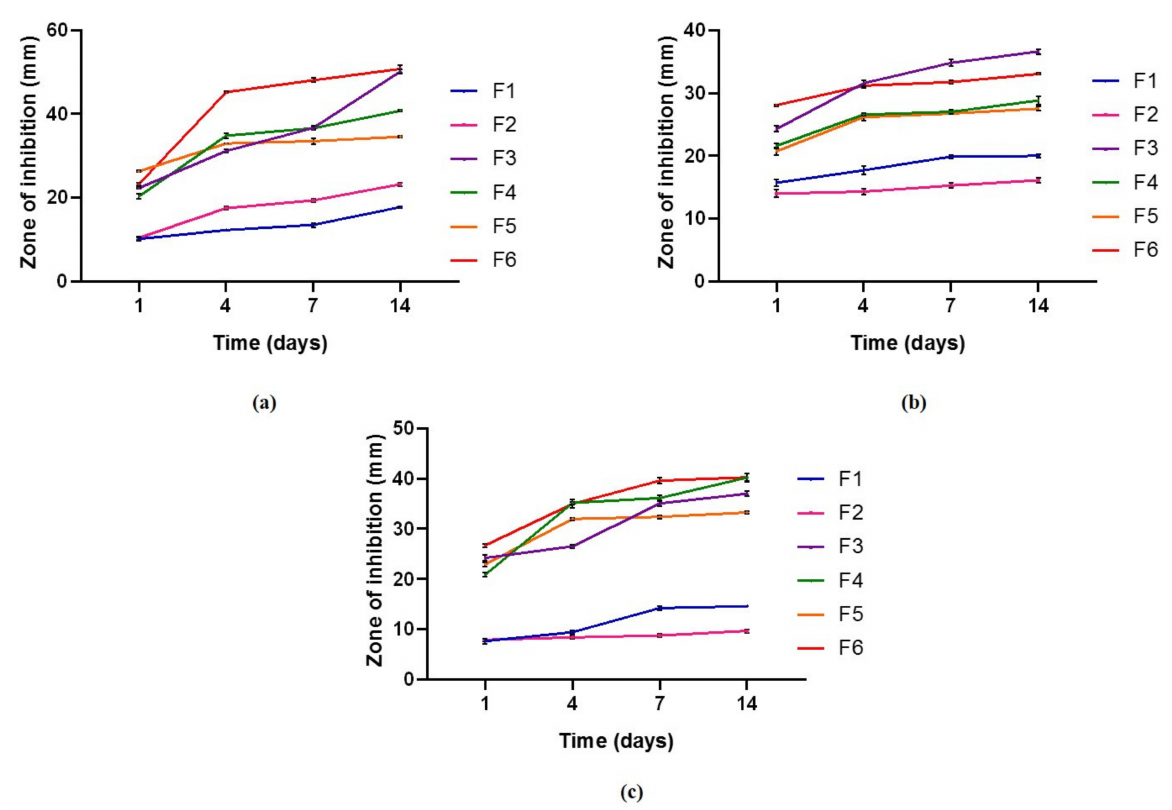
Figure 4. Zone of inhibition (mm) for p(HEMA) hydrogel as a control and the drug-loaded p(HEMA) hydrogel data represent at least 6 replicates in two independent experiments. ( a ) ZOI of S. aureus (n = 6 ± S.D.), ( b ) ZOI of E. coli (n = 6 ± S.D.), and ( c ) ZOI of P. aeruginosa (n = 6 ±